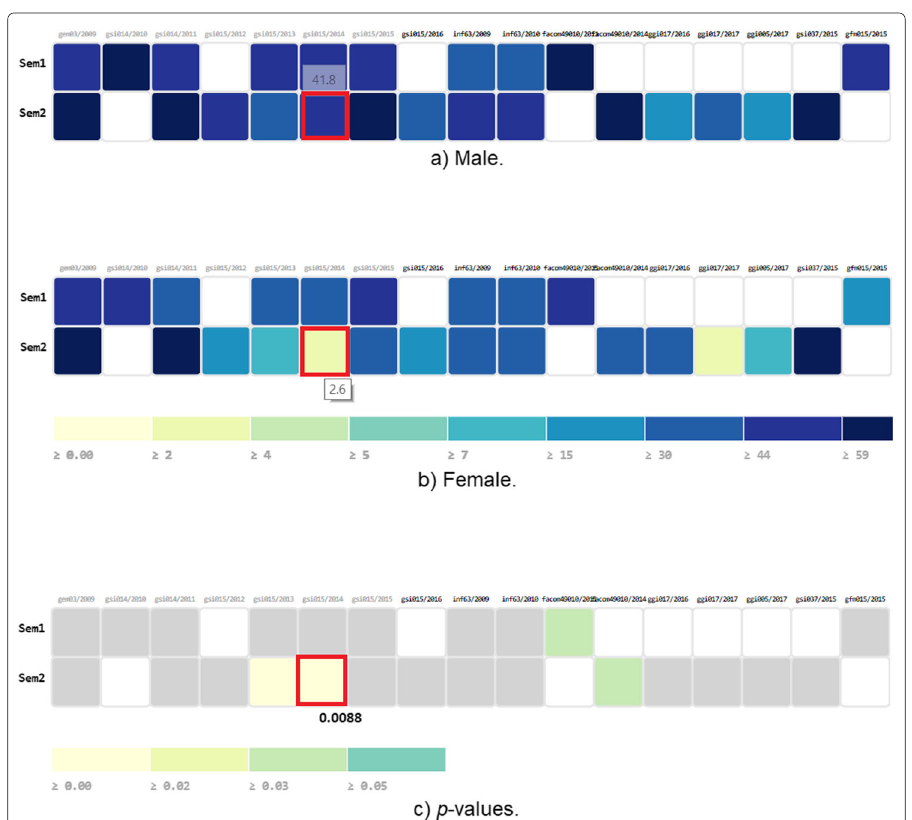
Fig. 4 Heatmap Matrix visualization of Gender vs. Grade for both genders and for associated p -values